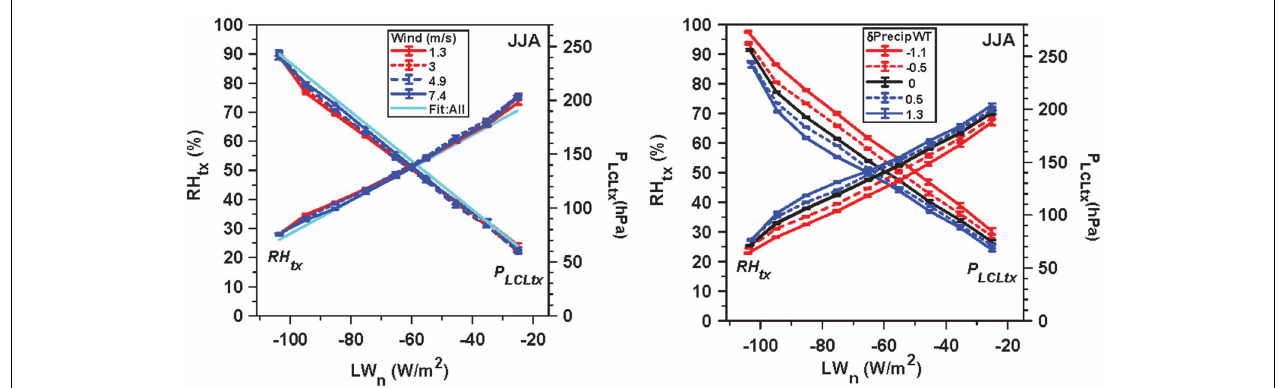
FIGURE 14 | LW n dependence of RH tx and P LCLtx , for the windspeed and precipitation anomaly stratifications.